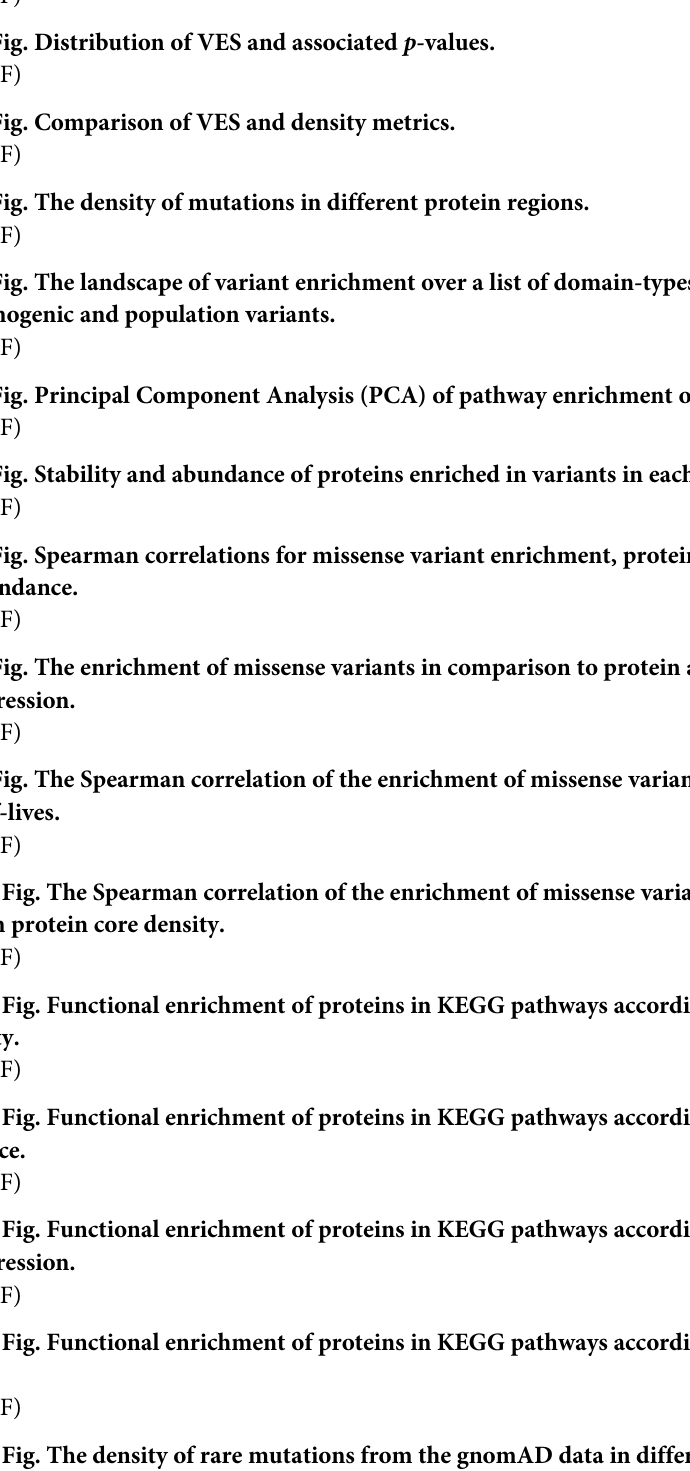
(PDF) S1 Fig. Distribution of VES and associated p -values. (PDF) S2 Fig. Comparison of VES and density metrics. (PDF) S3 Fig. The density of mutations in different protein regions. (PDF) S4 Fig. The landscape of variant enrichment over a list of domain-types most enriched in pathogenic and population variants. (PDF) S5 Fig. Principal Component Analysis (PCA) of pathway enrichment of protein-wise VES. (PDF) S6 Fig. Stability and abundance of proteins enriched in variants in each dataset. (PDF) S7 Fig. Spearman correlations for missense variant enrichment, protein stability, and abundance. (PDF) S8 Fig. The enrichment of missense variants in comparison to protein abundance and expression. (PDF) S9 Fig. The Spearman correlation of the enrichment of missense variants with protein half-lives. (PDF) S10 Fig. The Spearman correlation of the enrichment of missense variants in protein cores with protein core density. (PDF) S11 Fig. Functional enrichment of proteins in KEGG pathways according to thermal sta- bility. (PDF) S12 Fig. Functional enrichment of proteins in KEGG pathways according to protein abun- dance. (PDF) S13 Fig. Functional enrichment of proteins in KEGG pathways according to transcript expression. (PDF) S14 Fig. Functional enrichment of proteins in KEGG pathways according to protein half- life. (PDF) S15 Fig. The density of rare mutations from the gnomAD data in different protein regions.